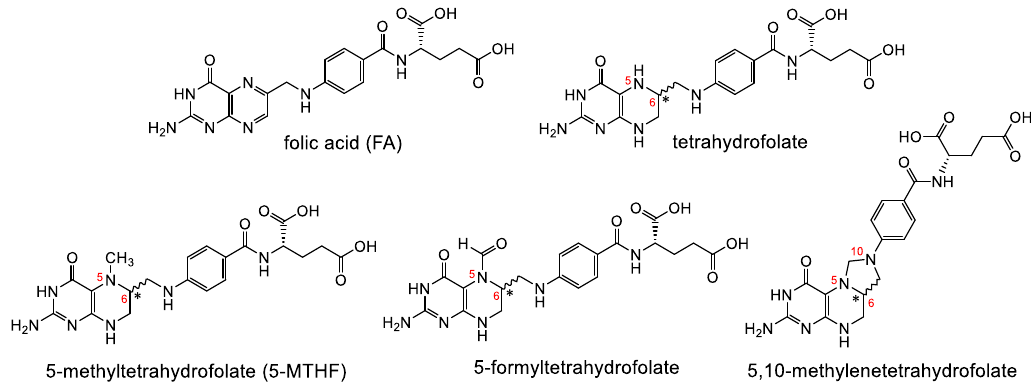
Figure 2. A selection of different forms of folates including the synthetic, fully oxidized FA and the endogenous reduced forms tetrahydrofolate, 5-MTHF, 5-formyltetrahydrofolate and 5,10-methylene- tetrahydrofolate. Reduced folates have a chiral center at position 6 of the pteroyl group. Mammals have three folate transporting systems: the reduced-folate carrier (RFC), the proton- coupled folate transporter (PCFT) and the folate receptor (FR) [3 – 6]. RFC is ubiquitously